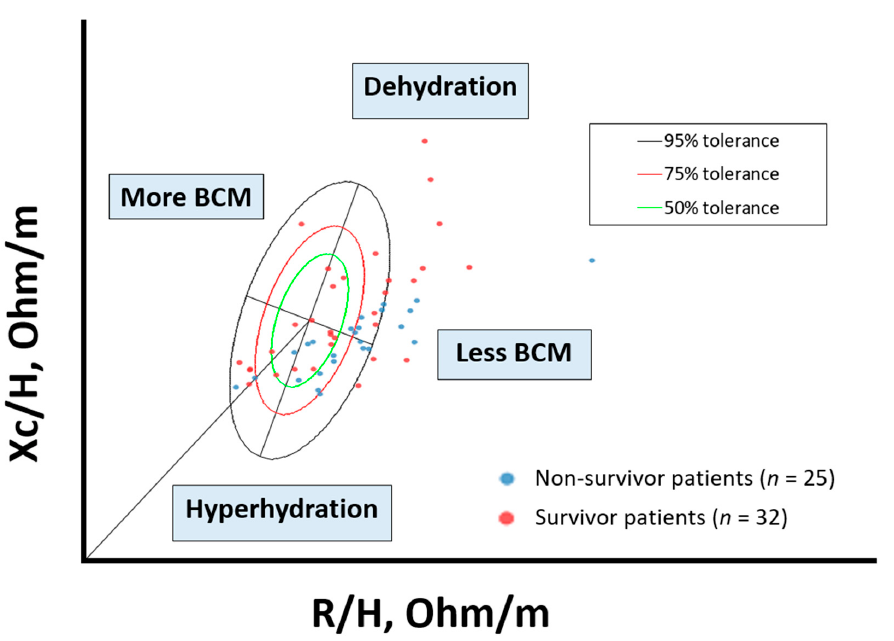
Figure 3. Scatterplot. Bioelectrical values of cancer disease: non-survivor patients ( n = 25) and survivor patients ( n = 32). BIA values: Rz/H (resistance/height, (Ohm/m)); Xc/H (reactance/height, (Ohm/h)), standardized by gender and age using bioelectrical Italian standards. The lower right quadrant encompasses patients with decreased body cell mass (BCM) and hyperhydration, most of the deceased patients. To interpret the color references in this figure legend, please see the Web version of this article. Source: own elaboration.